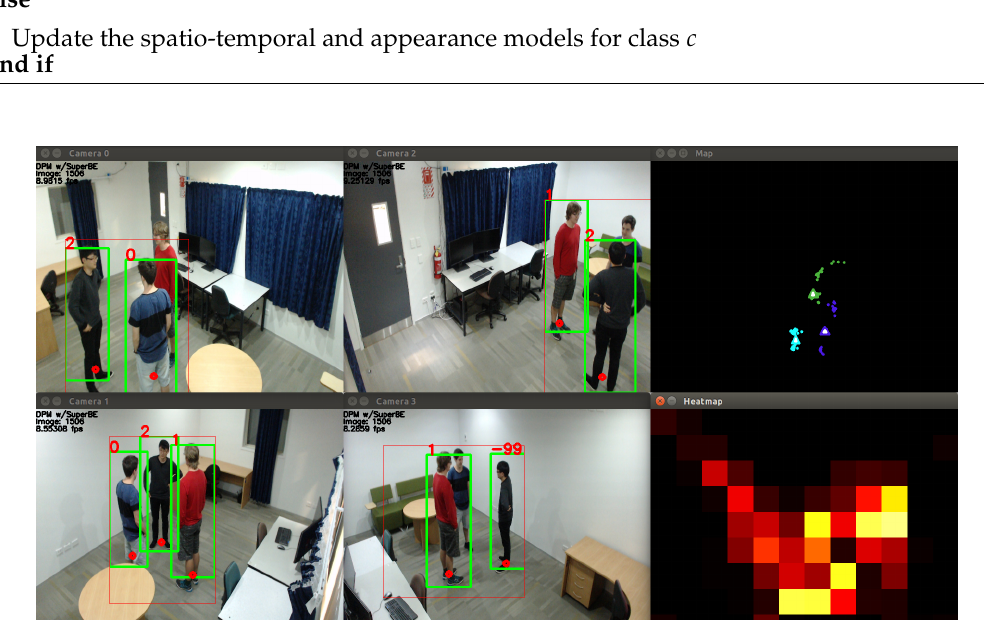
Figure 7. An example of a group of three people being tracked and identified correctly. In each camera view, the thin red box indicates the area that is isolated during background estimation for further processing, the green boxes represent the detected people, and the red circles represent the estimated position for each of those people. They have consistent ID numbers between the cameras (shown in red above each person), where − 99 indicates low certainty (and is ignored). The maps show the positions of the individuals, with the top of the map matching the wall with curtains shown in Camera 0 and 2. The top-right map shows the last fifty detections per class as circles and the estimated future position from the Kalman Filters as triangles. The bottom-right heatmap shows the most occupied areas of the room since system initialisation, quantised to 40 cm × 40 cm patches, where lighter/brighter colours indicate higher